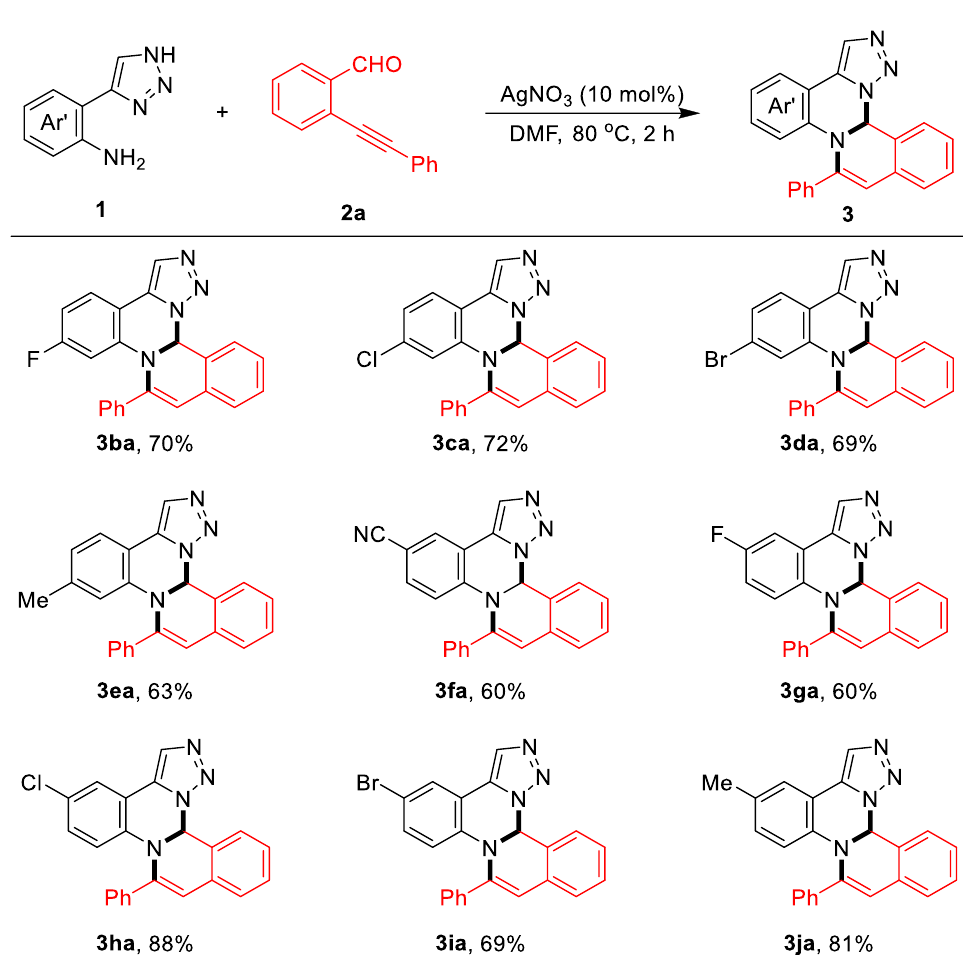
Figure 3. Scope of 2-(1 H -1,2,3-triazol-5-yl)aniline . Reaction conditions: 1a (0.2 mmol), 2 (0.2 mmol), AgNO 3 (10 mol%) in DMF (1 mL) at 80 °C for 2 h. Isolated